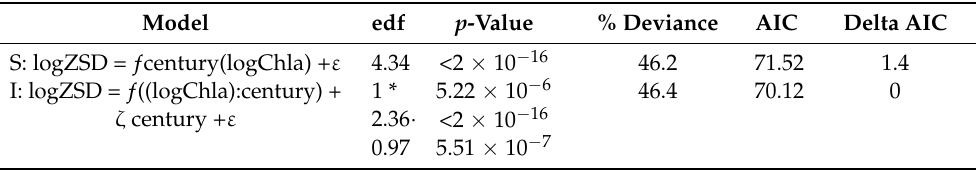
I: logZSD = ƒ((logChla):century)